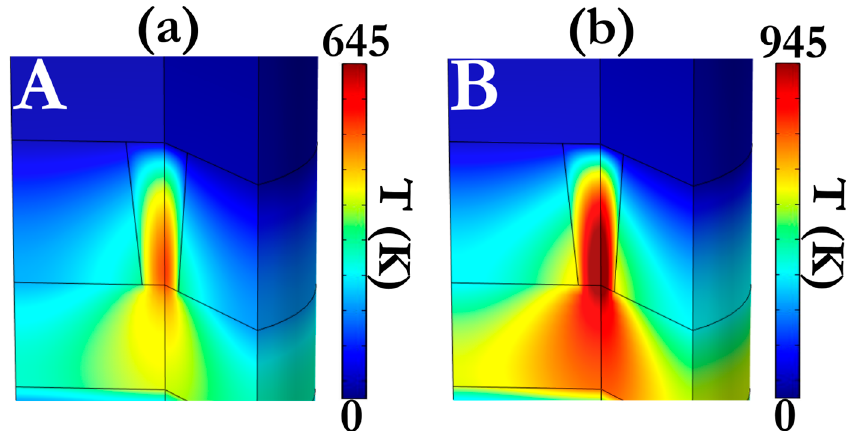
Figure 11. Three-dimensional calculated maps of the localized temperature distribution for ( a ) state A (+0.3 V) and ( b ) state B ( − 0.05 V).